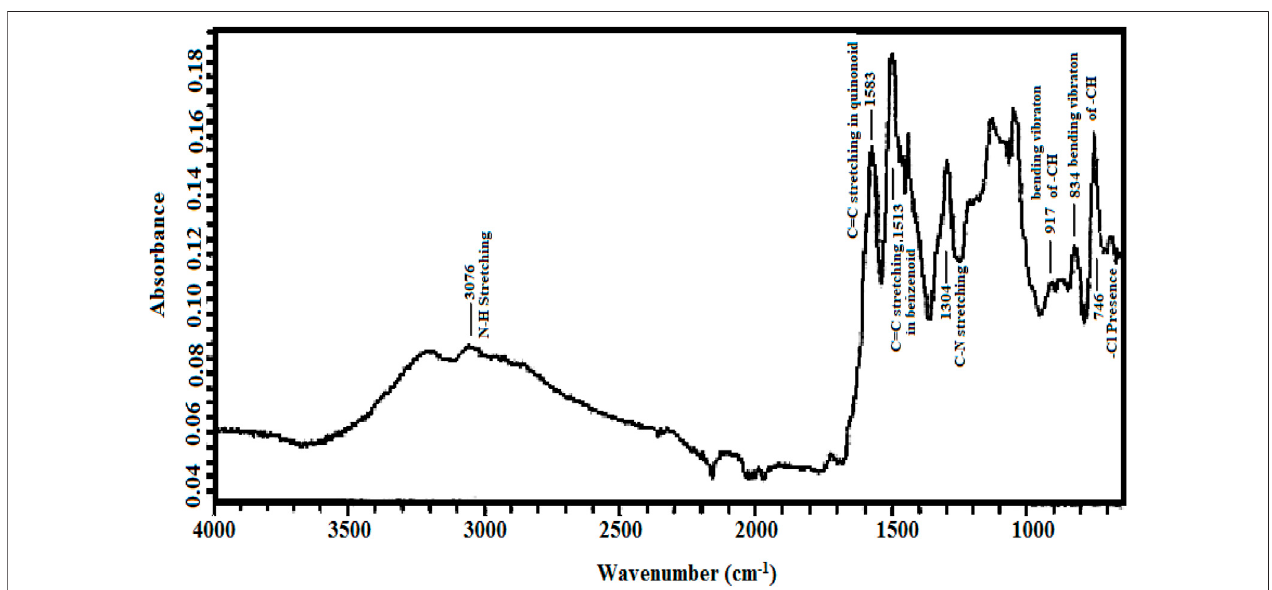
FIGURE 3 | FTIR spectrum of pure